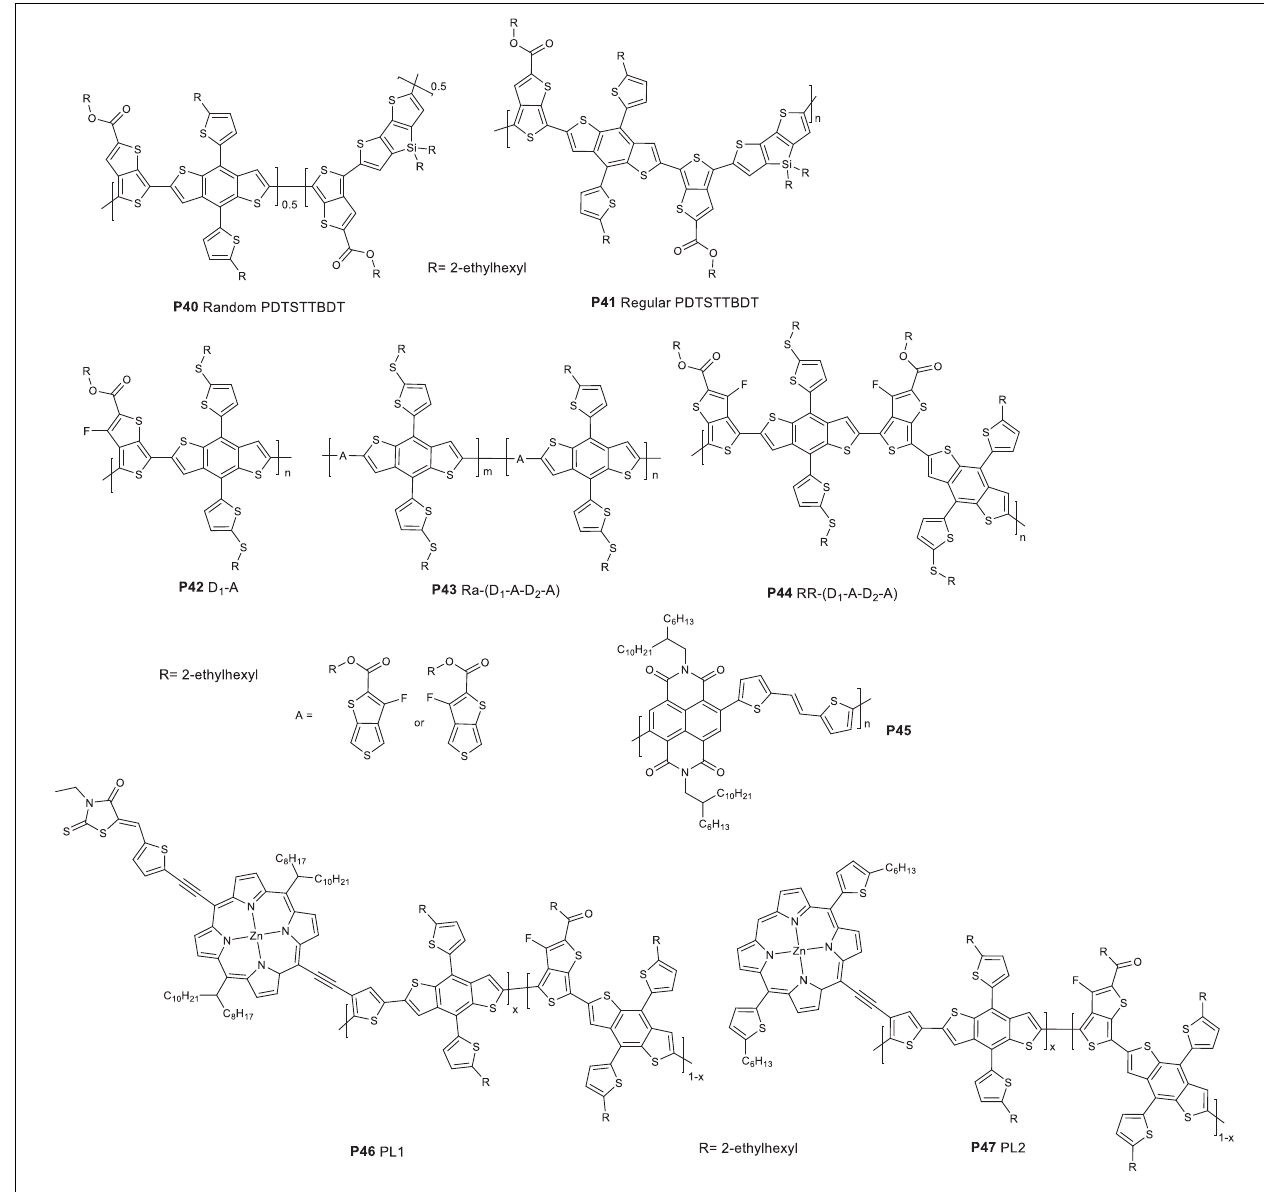
FIGURE 5 | Donor polymers with TT molecular acceptor unit ( P40 – P47 ).